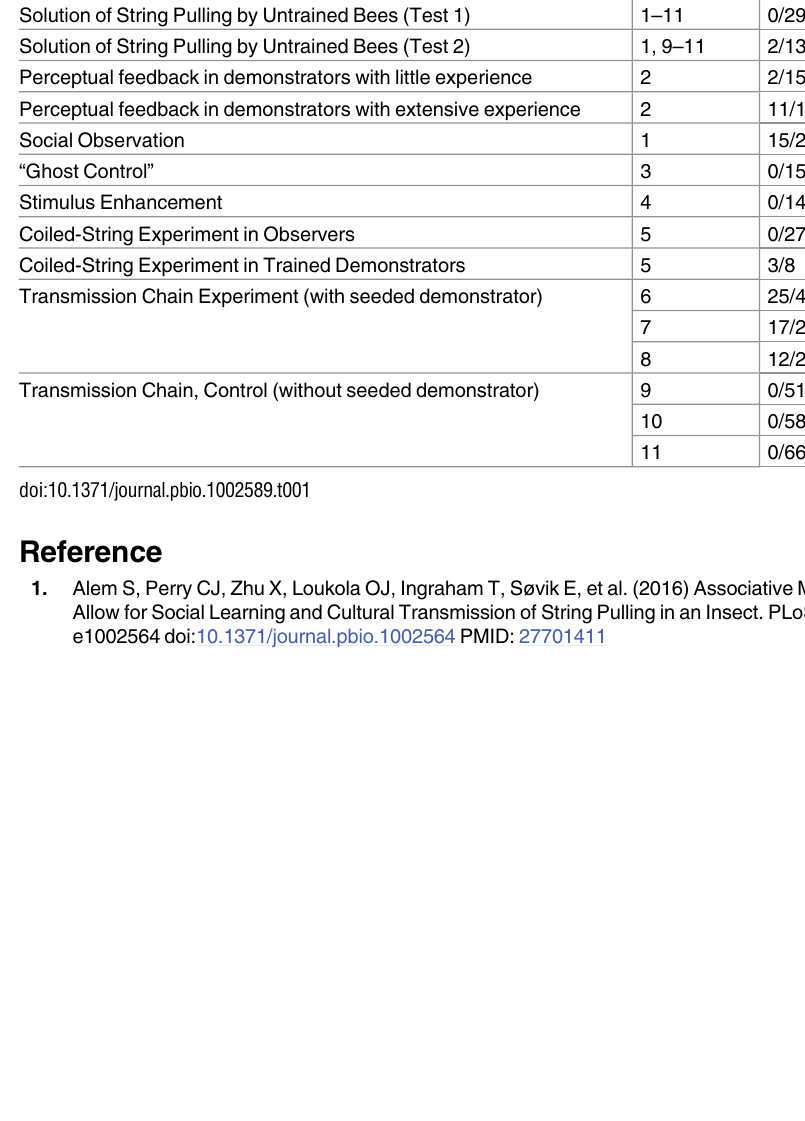
Table 4. Experiment Summary Table. Summary of all experiments, includingname, number of colony or coloniesused, sample size, and success rate of observedindividuals. Experiment Colony Success rate N String-Pulling Training 1 23/40 Solution of String Pulling by Untrained Bees (Test 1) 1–11 0/291 Solution of String Pulling by Untrained Bees (Test 2) Perceptual feedback in demonstrators with little experience Perceptual feedback in demonstrators with extensive